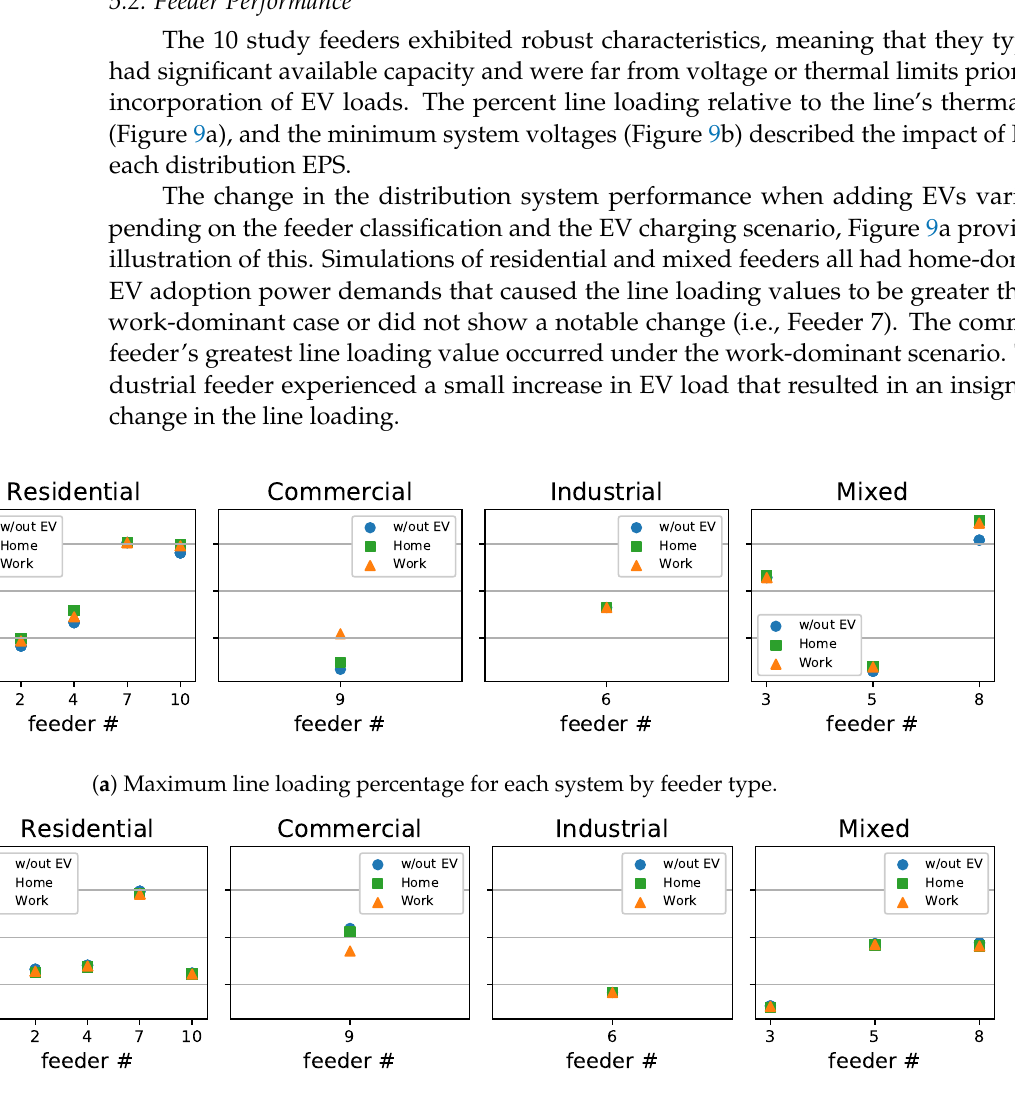
Figure 9. Each feeders’ performance varied slightly when subjected to the home and work-dominant Electric Vehicle (EV) charging scenarios. ( a ) increases in the maximum line loading tended to be largest in the home-dominant case for residential and mixed use feeders, and the work-dominant impacted the commercial feeder the most. ( b ) The EV chagrining had very little impact on each of the feeders’ voltage; The most significant change occurred in the commercial feeder under the work-dominant charging